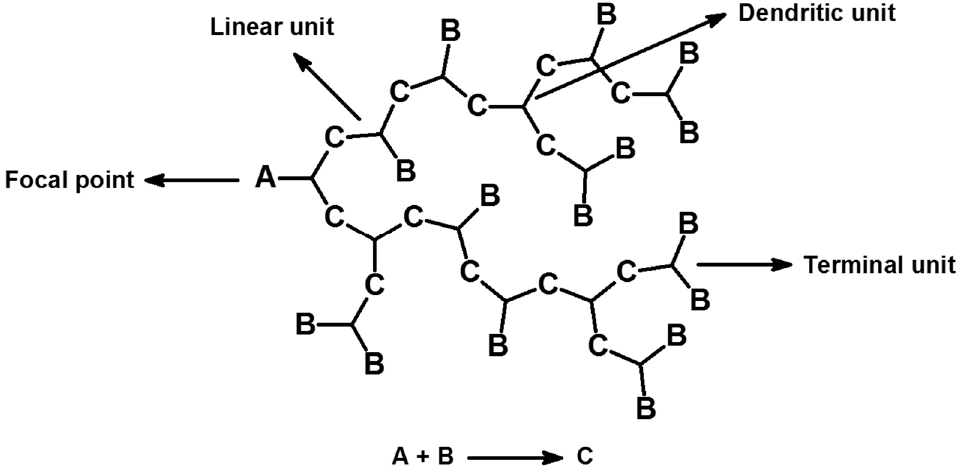
Figure 2. Different segment types in HMs.